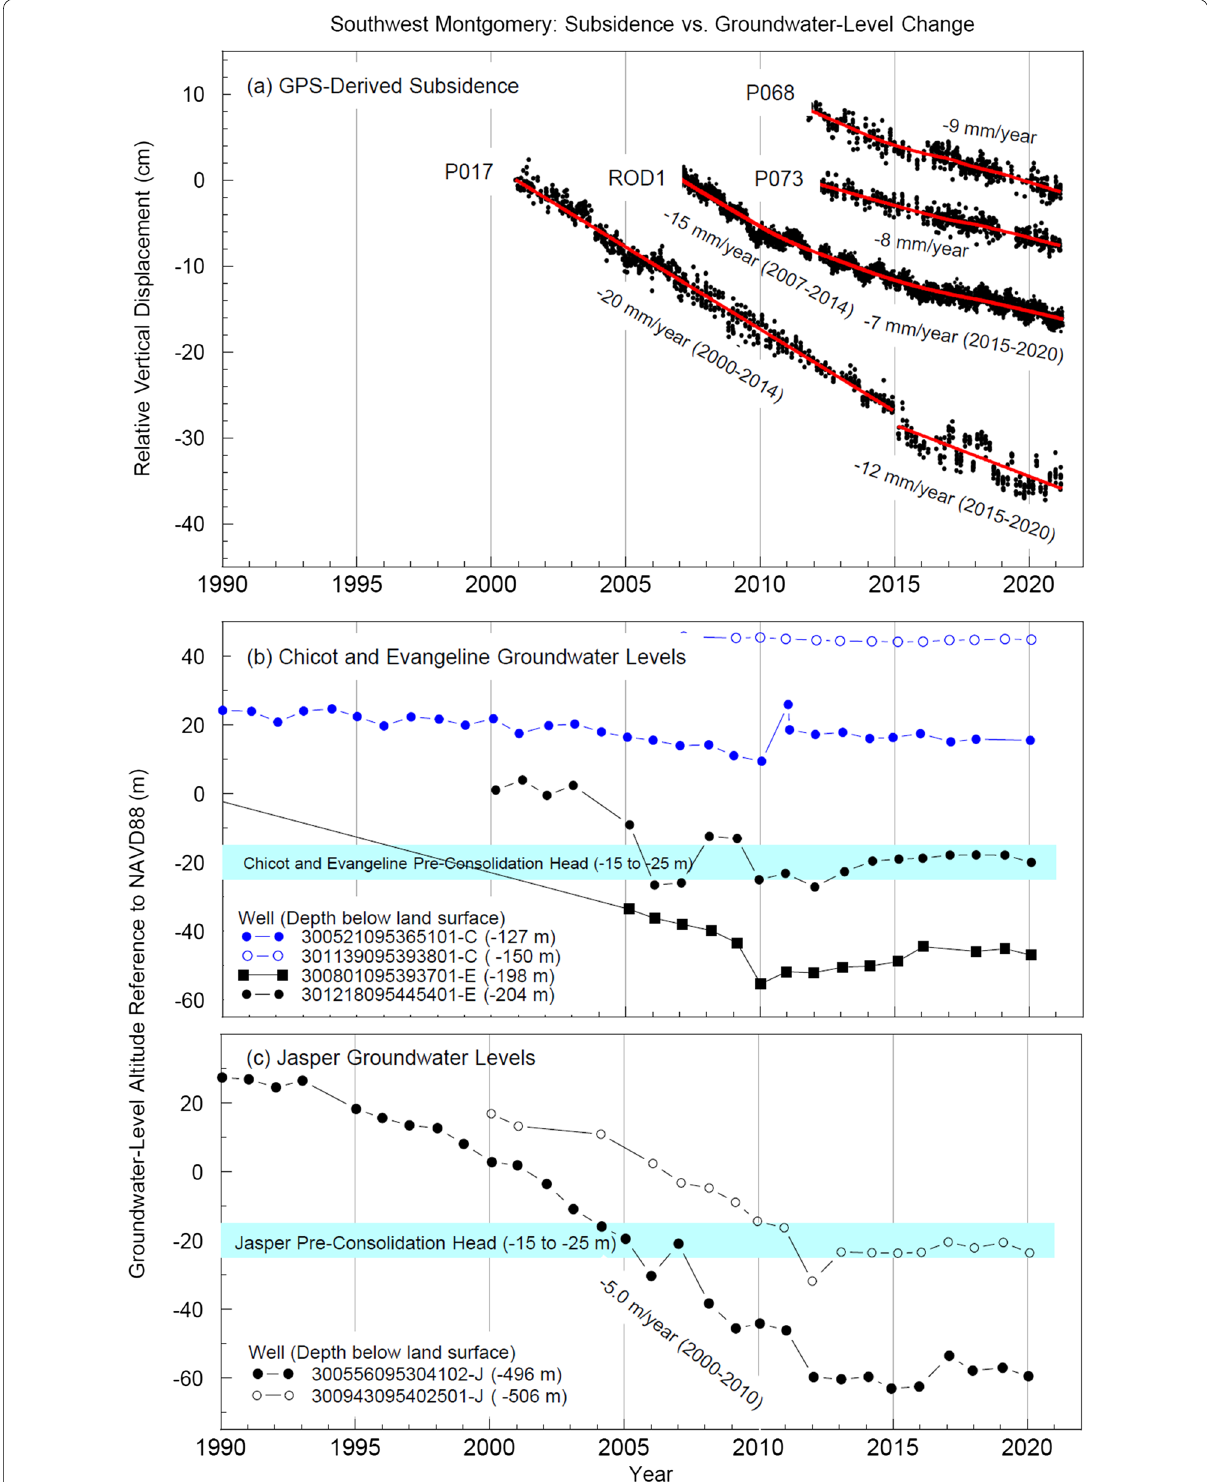
Fig. 17 GPS-derived land subsidence and groundwater levels in southwestern Montgomery County. The locations of GPS stations and groundwater wells are marked in Fig.